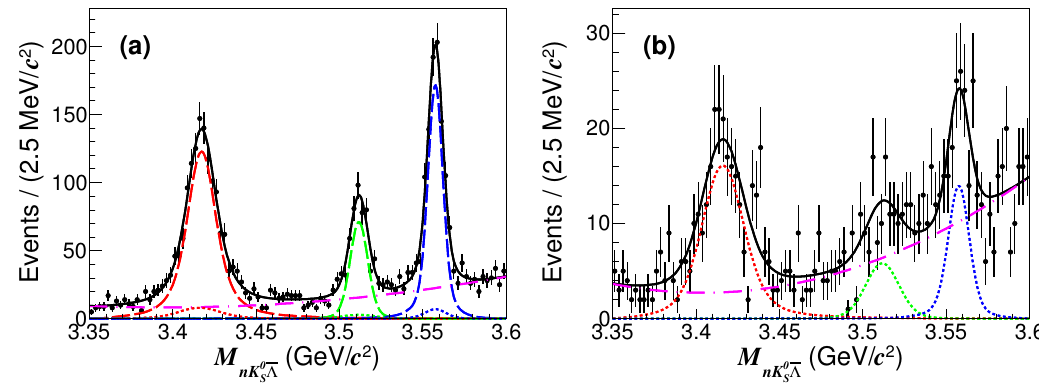
Figure 3 . Simultaneous fit to the M ¯Λ spectra in the (a) signal and (b) sideband regions. The nK 0 S points with error bars are data. The black solid lines represent the total fit. The red, green, and blue dashed lines represent the signals of χ c 0 , χ c 1 , and χ c 2 , respectively, and the corresponding dotted lines illustrate the peaking backgrounds. The purple dotted-dashed lines show the fitted